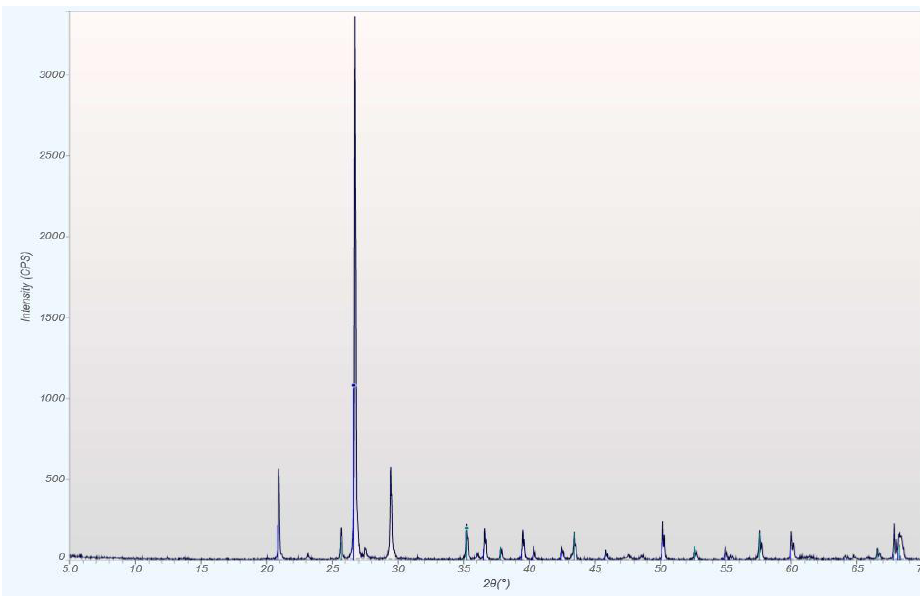
Figure D1: qXRD spectra for the sandstone sample SS-10.